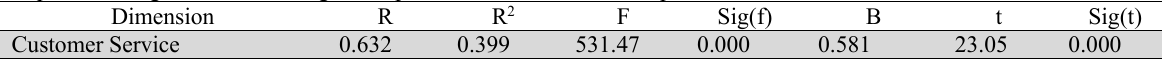
Simple linear regression for testing the impact of customer service on pharmacies selection